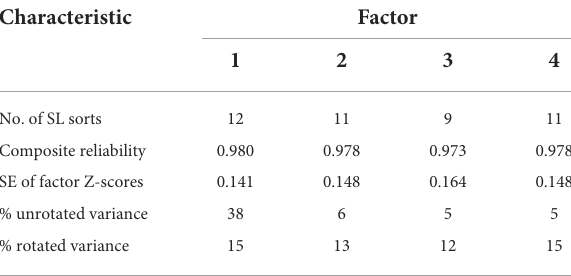
TABLE 4 Factors